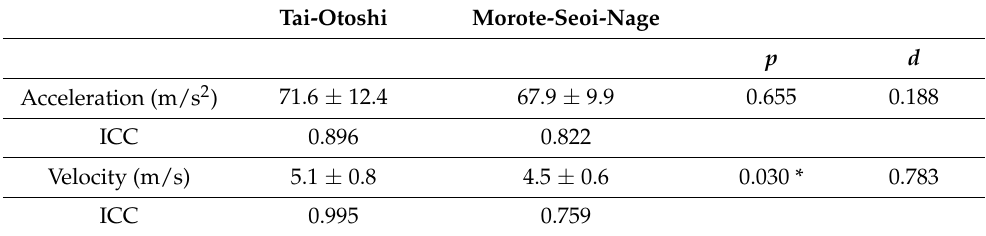
Table 2. Average peak acceleration and velocity of uke’s shoulder in tai-otoshi and morote-seoi-nage. Tai-Otoshi Morote-Seoi-Nage p d Acceleration (m/s 2 ) 71.6 ± 12.4 67.9 ± 9.9 0.655 0.188 ICC 0.896 0.822 Velocity (m/s) 5.1 ± 0.8 4.5 ± 0.6 0.030 * 0.783 ICC 0.995